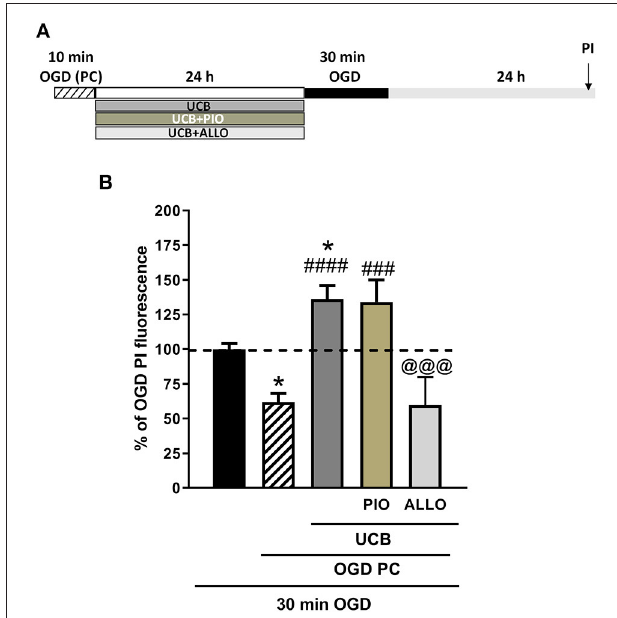
FIGURE 7 | Effects of unconjugated bilirubin (UCB), pioglitazone, and allopurinol on OGD neurotoxicity in OGD preconditioned immature organotypic hippocampal slices. (A) Experimental protocol showing immature hippocampal slices exposed to OGD preconditioning alone or plus UCB (100 µ M), pioglitazone (10 µ M), and allopurinol (10 µ M) for 24h and then to 30min OGD. (B) Quantitative analysis shows that OGD-preconditioning prevents cellular death in OGD exposed immature slices and that this effect is abolished by previous exposure to UCB. The addition of allopurinol but not pioglitazone is able to restore the protective effect of preconditioning. Bars represent the mean ± SEM of at least seven experiments (about ≥ 28 slices for each experimental point). * P < 0.05 vs. OGD; ### P < 0.001 vs. preconditioning; #### P < 0.0001 vs. preconditioning; @@@ P < 0.05 vs.